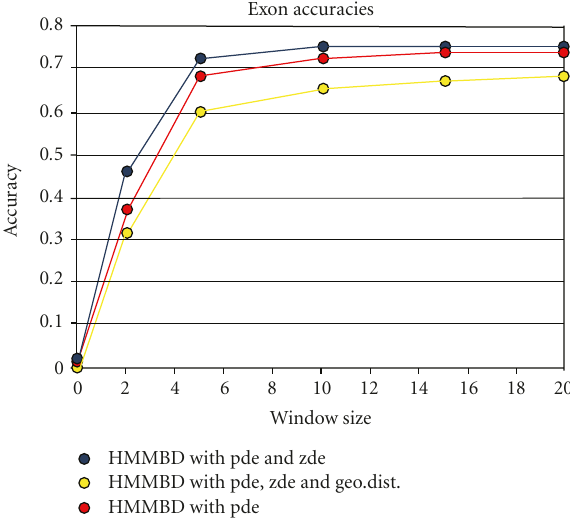
Figure 5: Exon level accuracy rate results for three di ff erent kinds of settings.